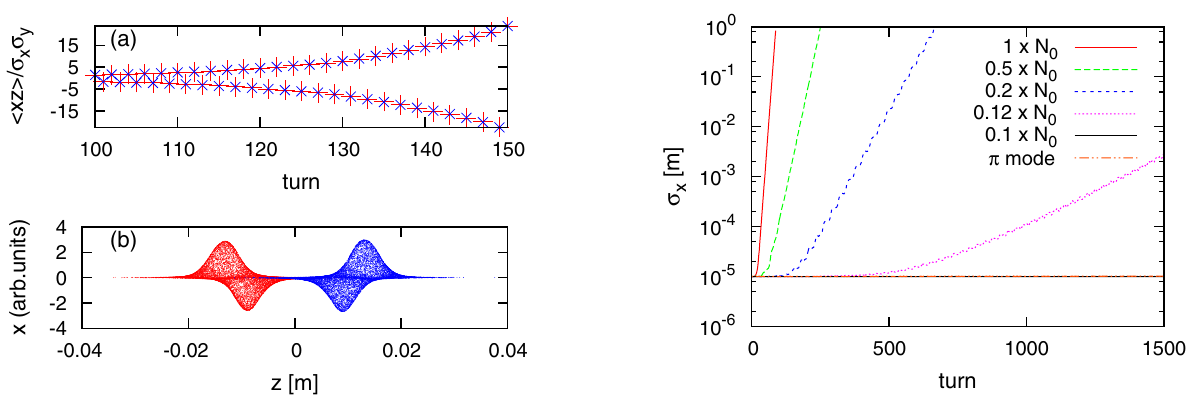
is scanned x ¼ 10 , ν ¼ 0 . 54 , P x